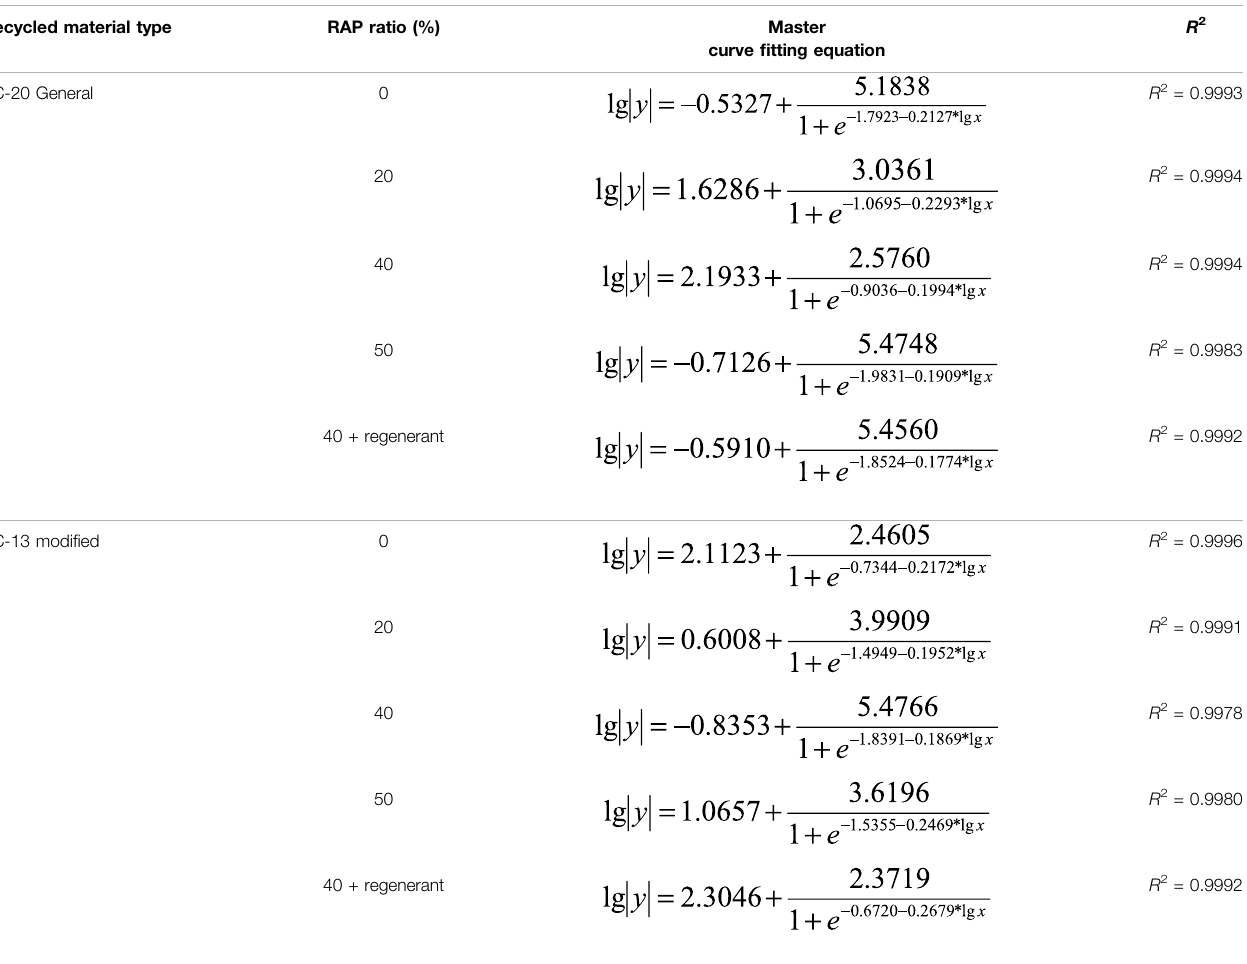
TABLE 6 | Master curve fi tting equations for different asphalt recycled mixes at 20 ° C. Recycled material